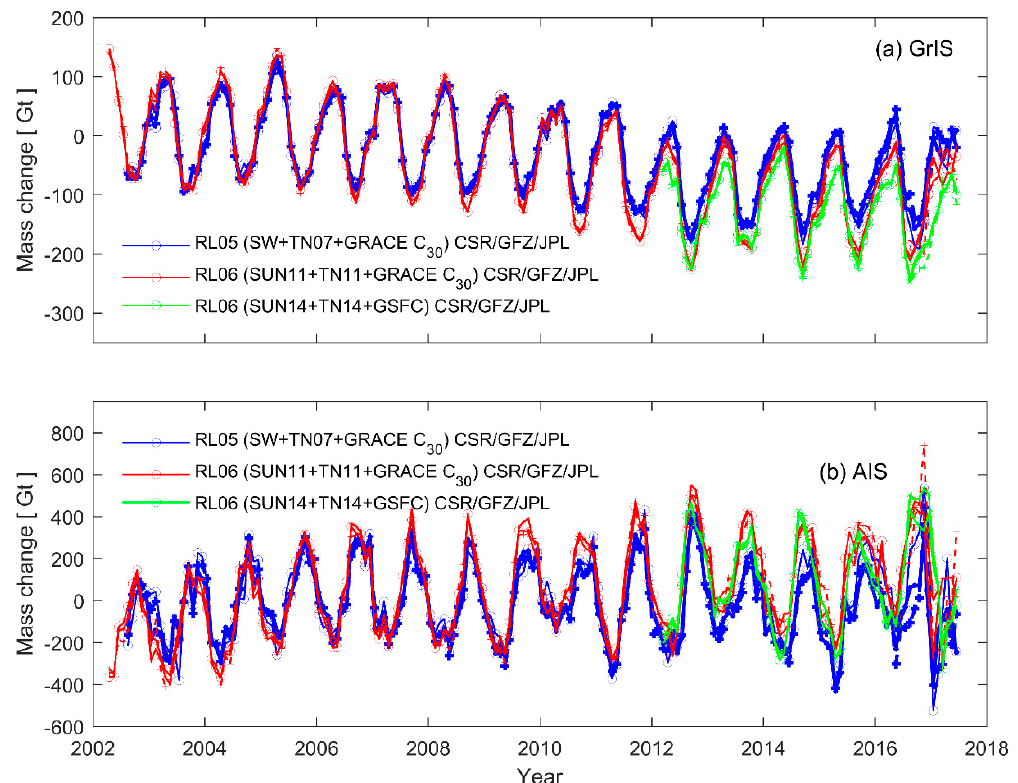
Figure 5. Mass change time series computed by the combination of degree one terms, SLR-based C 20 estimates, and C 30 solutions corresponding to CSR / GFZ / JPL-published GRACE RL05 and RL06 data over ( a ) the GrIS and ( b ) the AIS during the GRACE mission span. CSR / GFZ / JPL means time series of mass change caused by the combination of degree one terms, SLR-based C 20 and GRACE-determined C 30 estimates from CSR, GFZ, and JPL, are separately calculated and shown. Table 6. The trends of mass change time series caused by the combination of degree one terms, SLR-based and estimates corresponding to GRACE RL05 and RL06 data over the GrIS and the AIS during the period from August 2002 to July 2016.